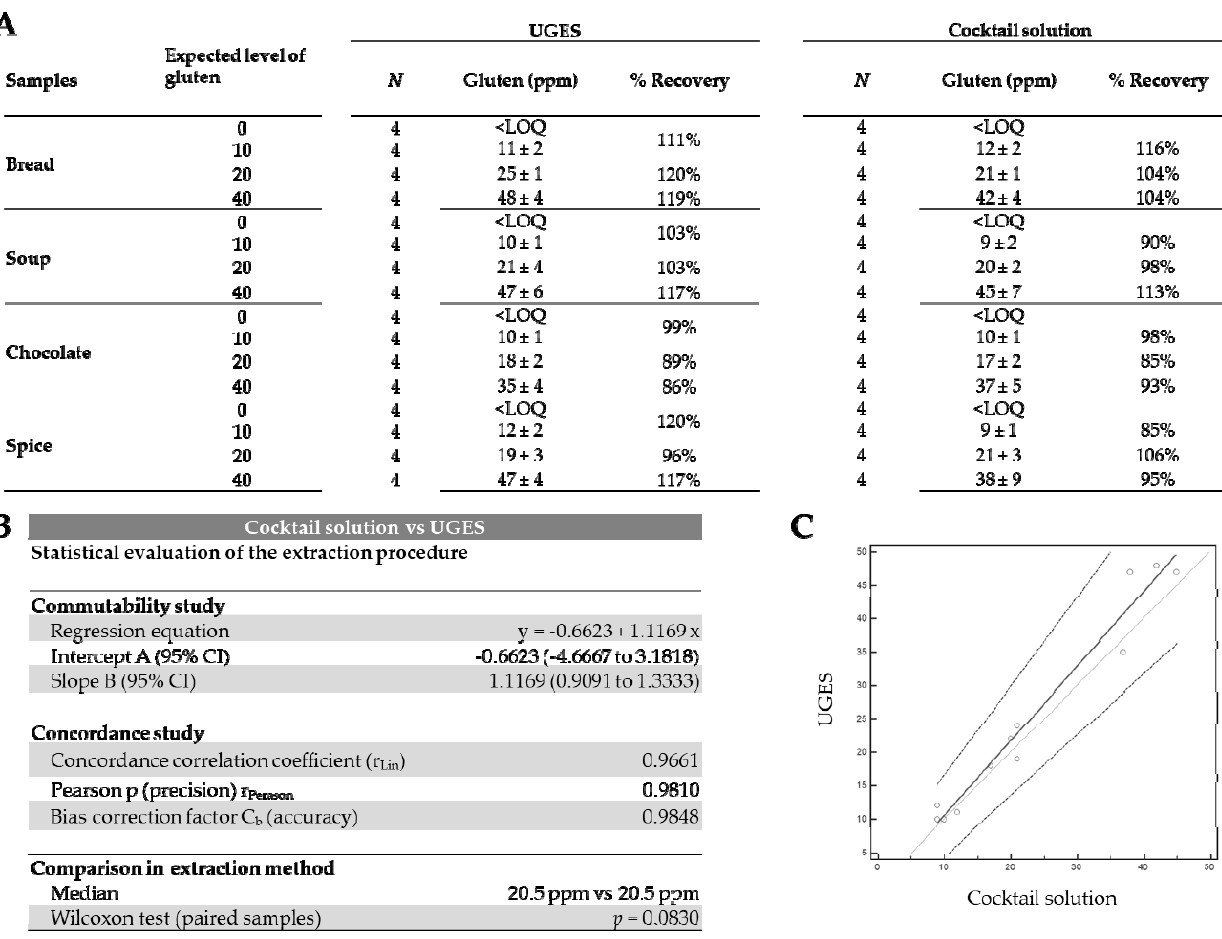
Figure 3. Analysis of spiked samples by sandwich ELISA after extraction with Universal Gluten Extraction Solution (UGES) and Cocktail solutions. ( A ) Recovery of the different levels of gluten provided in the food samples. Results are expressed as ppm of gluten (mean ± SD) and percentage of gliadin recovery (R). N = number of analyses. ( B ) Comparison of agreement between pairs of assays for results of the food samples by sandwich ELISA with different extraction solutions. ( C ) Scatter diagram with regression line and concordance bands for regression line, indicative of commutability. <LOQ, less than the limit of quantification.